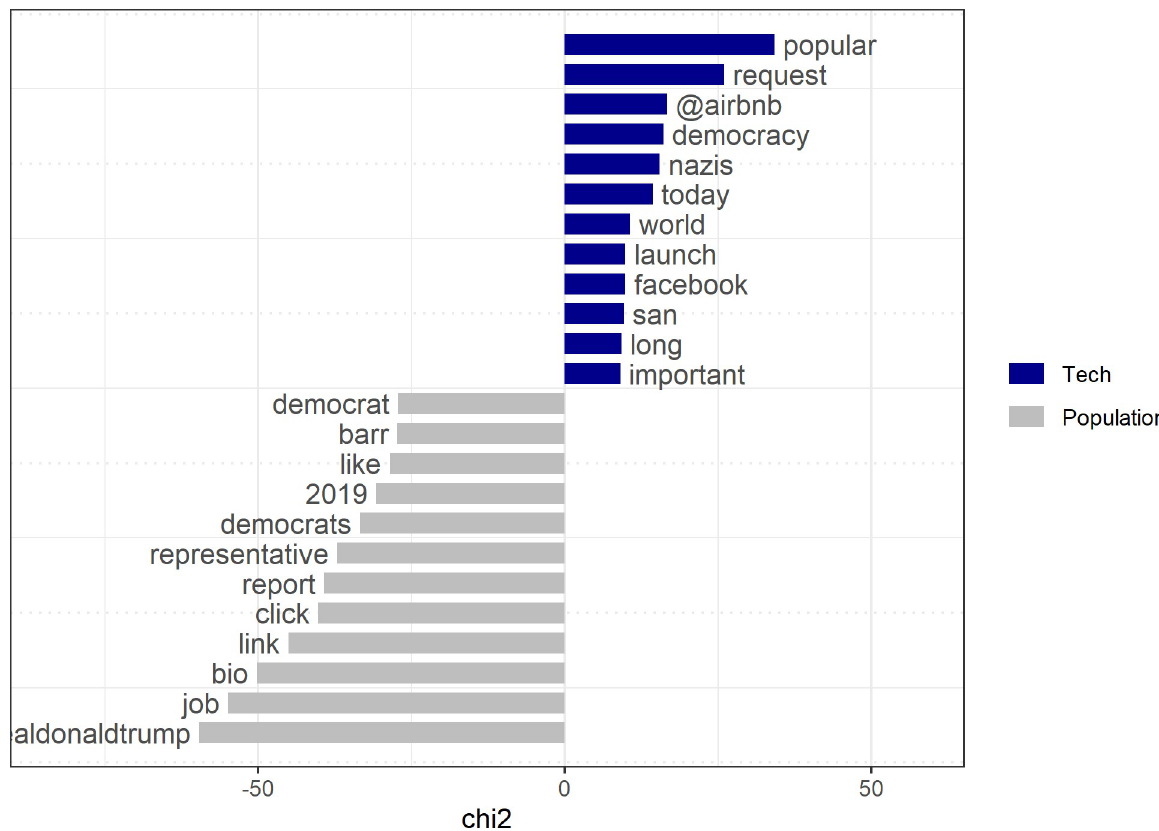
Fig 11. Keyness statistics for tweets for “democracy” and related words.